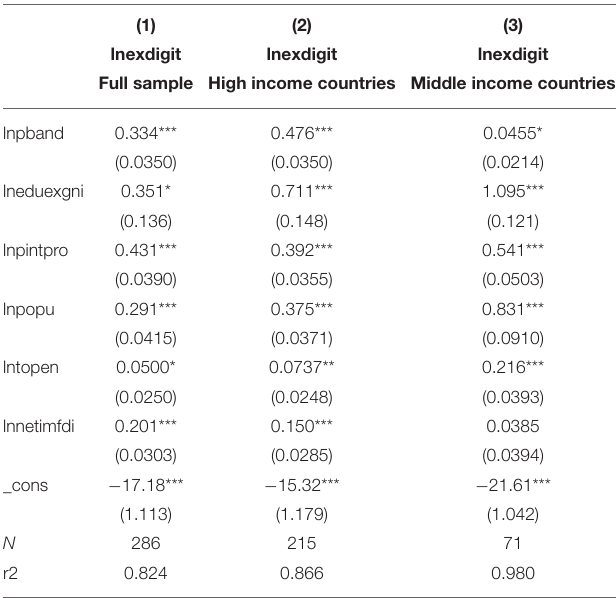
TABLE 4 | Heterogeneity